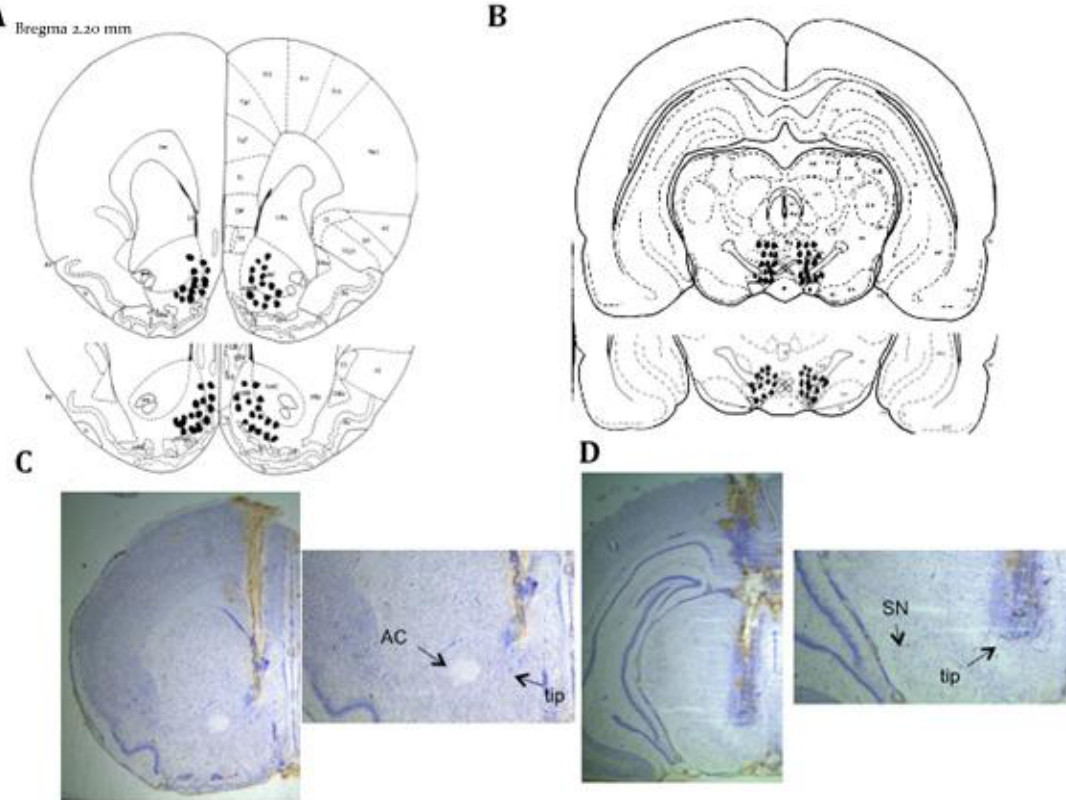
Figure 1. Dropsites for ventral tegmental area (VTA) and nucleus accumbens septi (NAcc) Injector Cannula. Placement of injector cannula into the NAcc and VTA. Dots represent the deepest portion of the injector cannula tip. Some dots represent more than one